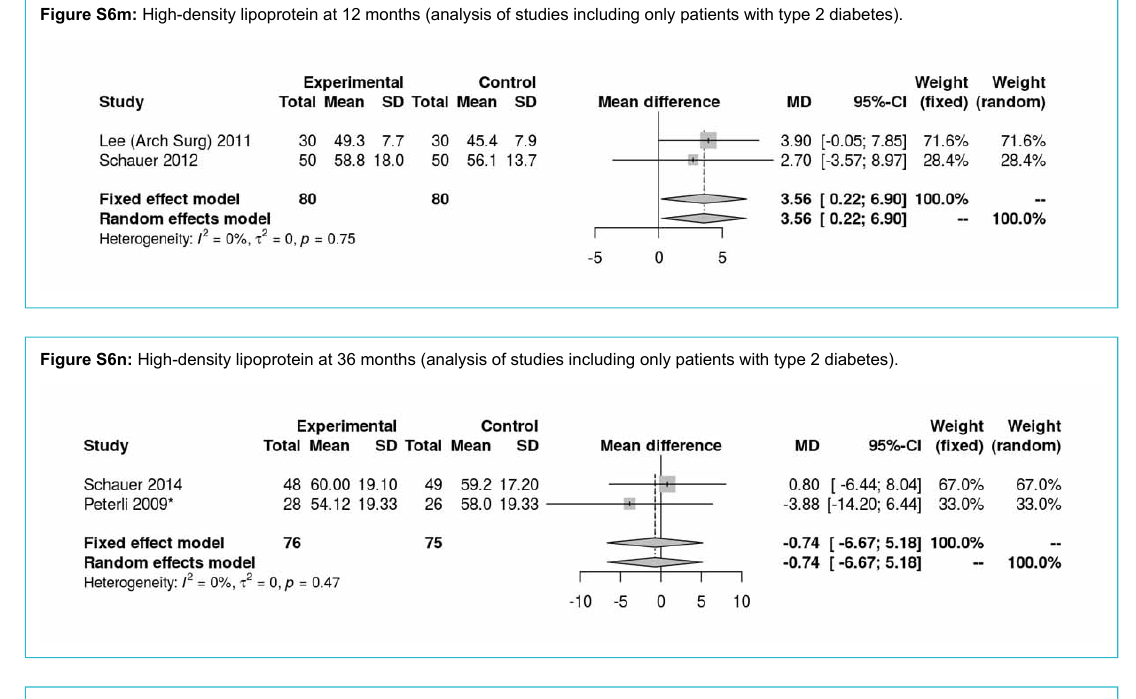
Figure S6o: Cholesterol at 12 months (analysis of studies including only patients with type 2 diabetes).